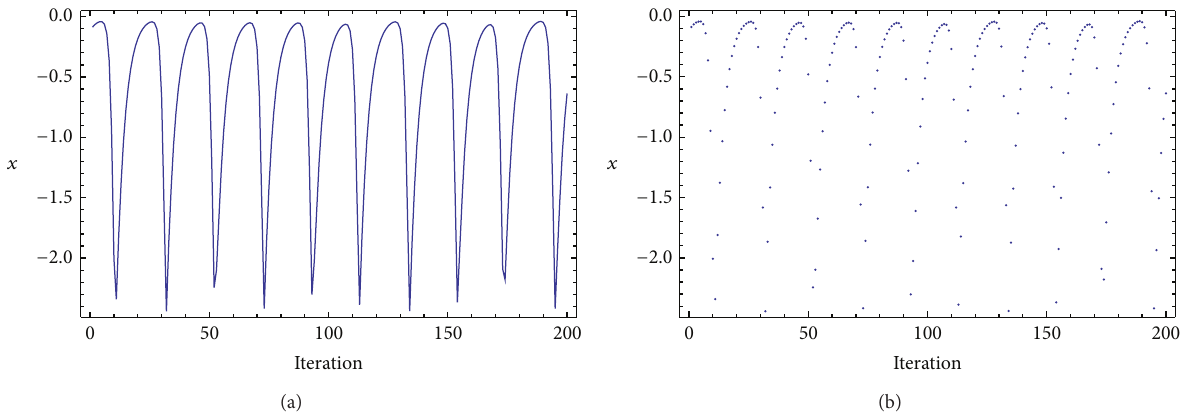
Figure 2: Iterations of the Burgers map (variable 𝑥 ) (a), iterations of the Burgers map (variable 𝑥 ), point-plot (b).